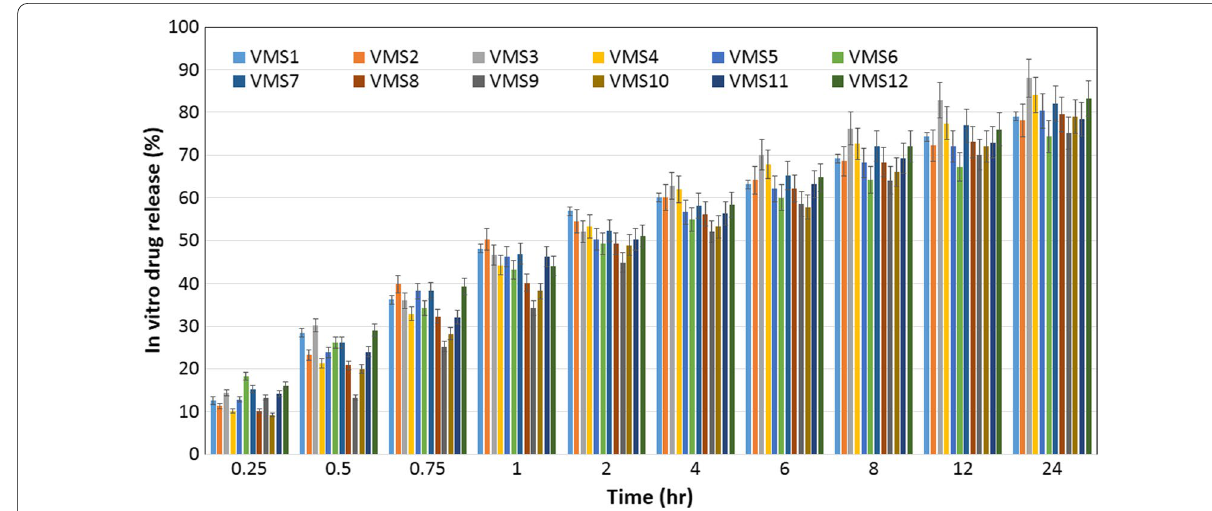
Fig. 5 In vitro drug release profile of VMS